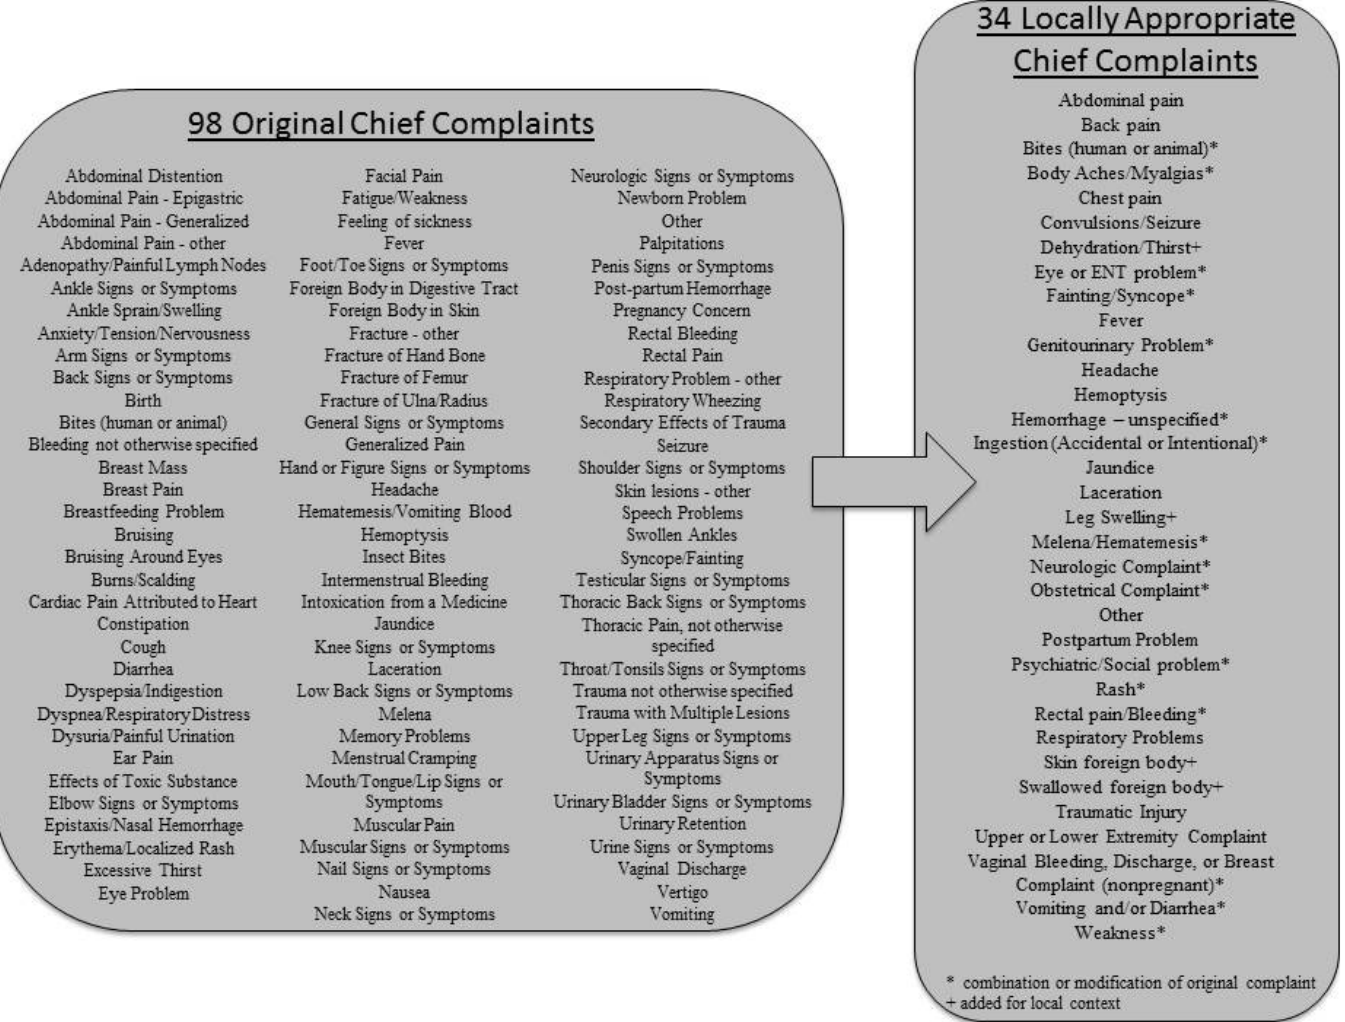
Figure 1. The development of categorization of locally appropriate chief complaints for Hospital Pedro Vicente Maldonado.